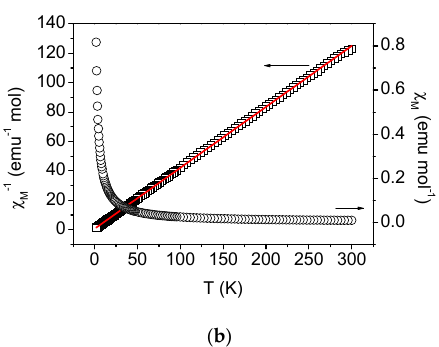
Figure 8. ( a ) Plots of χ m and χ m − 1 versus T for 1 . ( b ) Plots of χ m and χ m − 1 versus T for 2 . The solid lines are reproduced from the theoretical calculations and detailed fitting procedure described in the text.